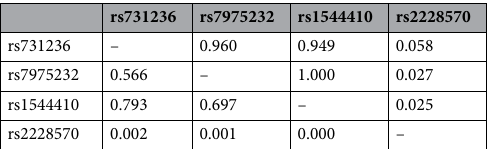
Table 3. Linkage disequilibrium across the study SNPs. D’ is shown above the diagonal; r 2 is shown below the